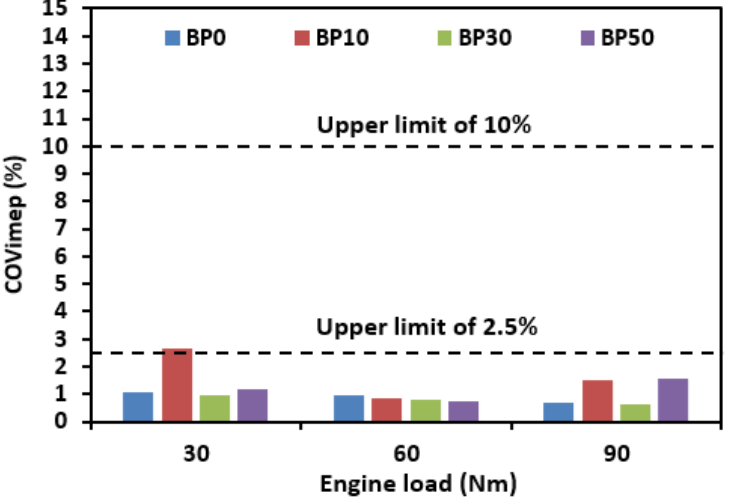
Figure 6. COVimep for all test fuels according to various engine loads.